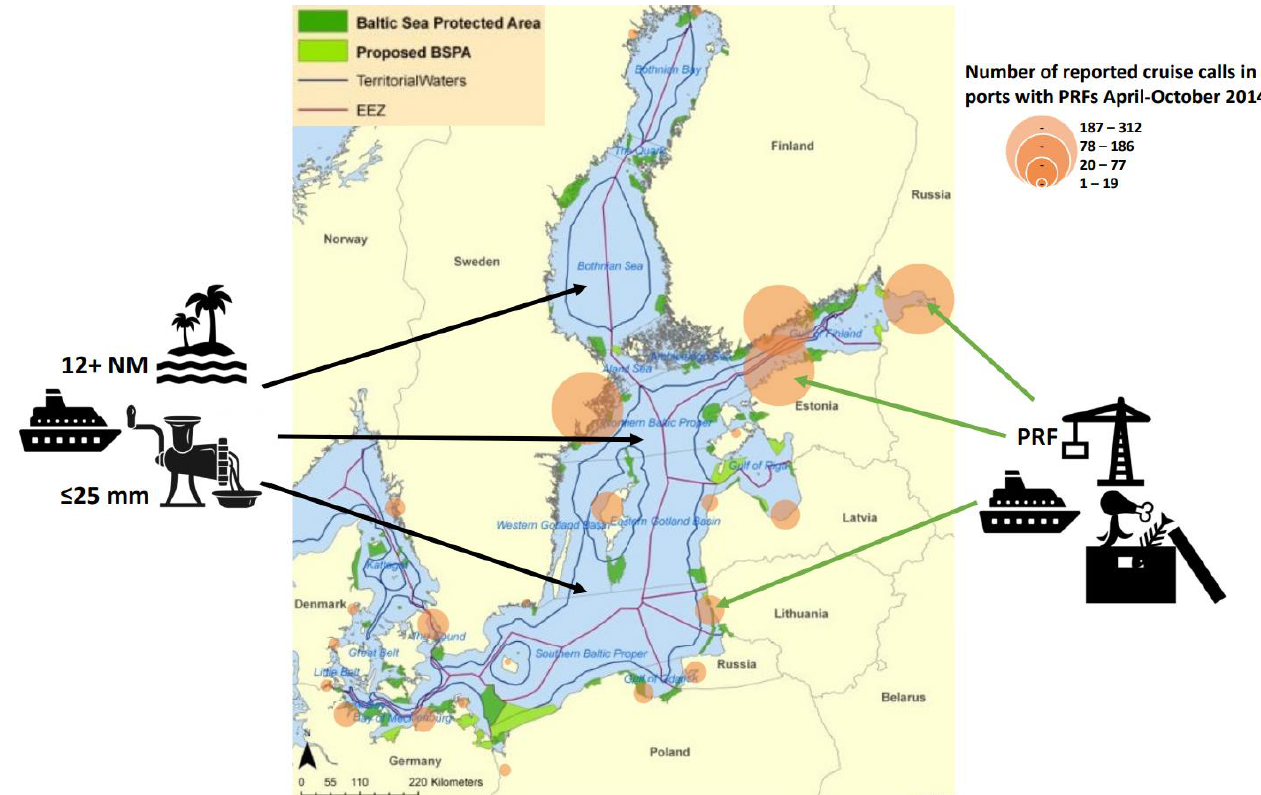
Figure 5. The Baltic Sea and locations of its sub-basins. The blue line shows the border of territorial waters (at least 12 NM from the nearest land) and the purple lines indicate the Exclusive Economic Zones (up to 3 NM from the nearest land). The green colour indicates existing (dark green) and proposed (light green) protected areas. Image from HELCOM, Baltic Sea protected areas map, 2008 [32], in combination with the list of ports most visited by cruise ships in 2014 [19], indicating the availability of the largest PRFs.